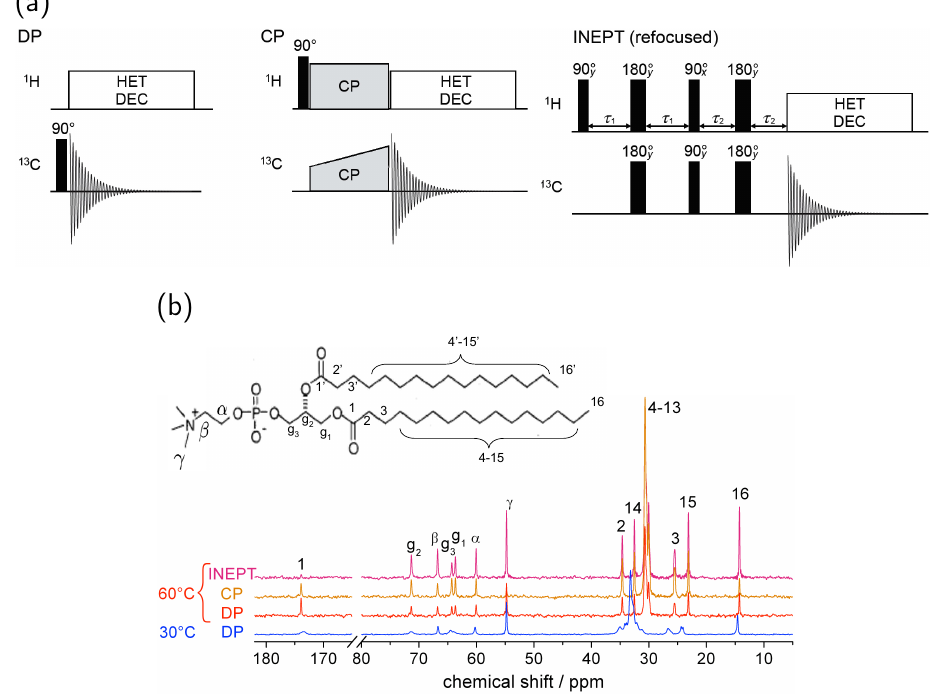
Figure 7. ( a ) Pulse sequences for the excitation of transverse 13 C magnetization; ( b ) 13 C MAS spectra of DPPC. Results for the temperatures 30 ◦ C and 60 ◦ C and for the excitation schemes DP, CP and (insensitive nuclei enhanced by polarization transfer) INEPT are compared. Note that due to broader lines, the spectrum at 30 ◦ C is measured with a considerably higher number of